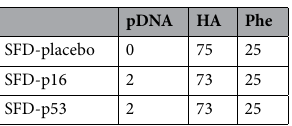
Table 1. Composition of Dry powders (%). Phe;